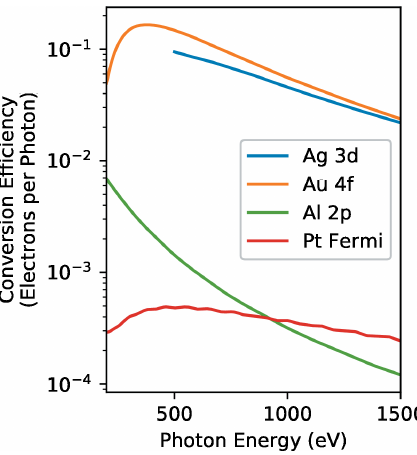
Figure 2 Photoemission quantum efficiency of some electronic subshells with potential for